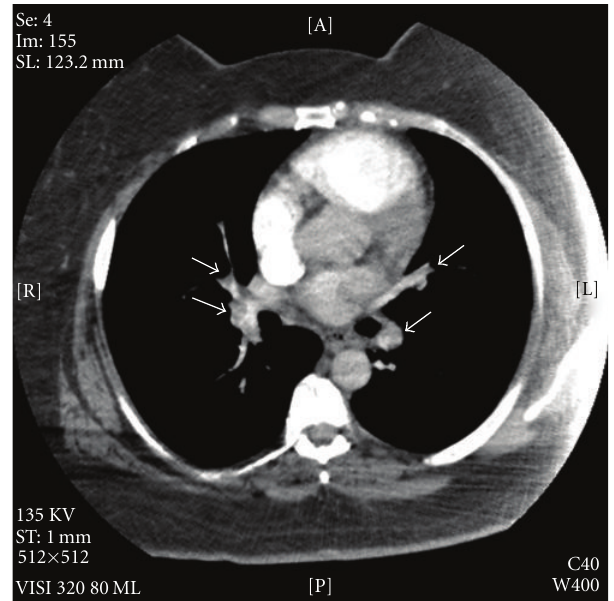
Figure 1: CT angiogram of the chest showing bilateral pulmonary emboli (arrows).